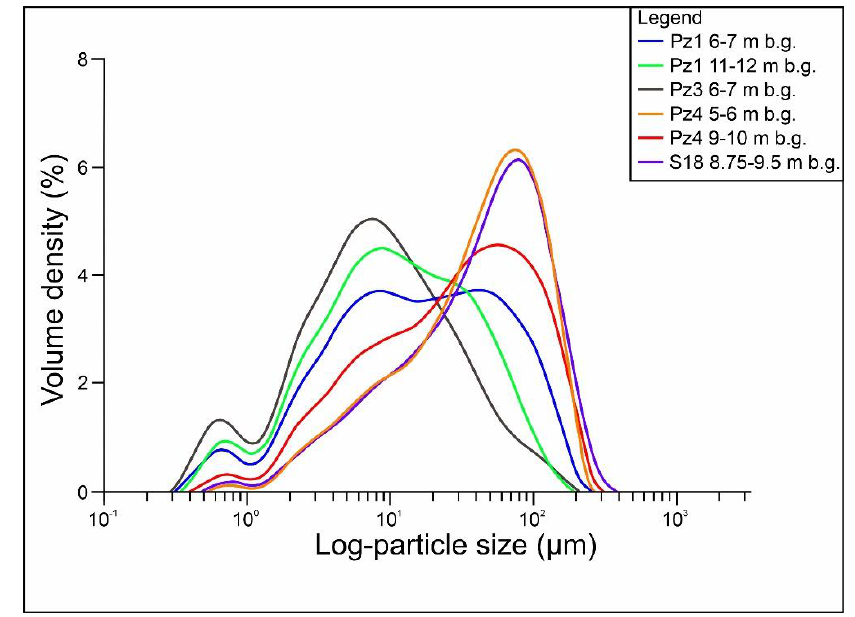
Figure 5. Comparison of the six average grain-size distribution curves.